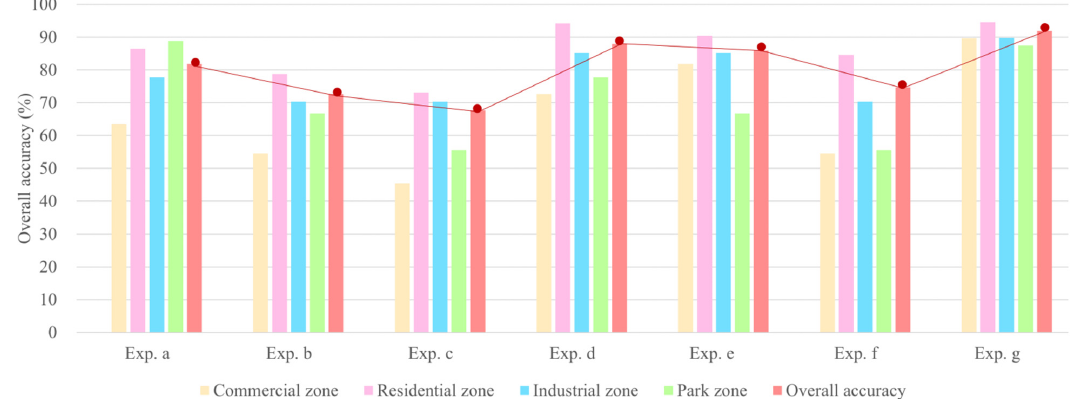
Figure 12. UFZ classification accuracy for different variables combination.